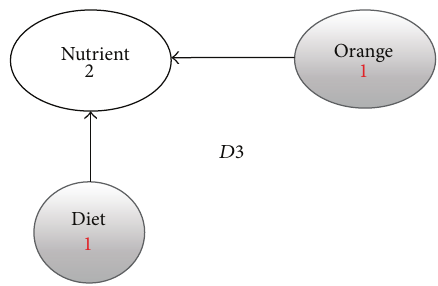
Figure 17: Frequencies after spreading activation for 𝐷3 .